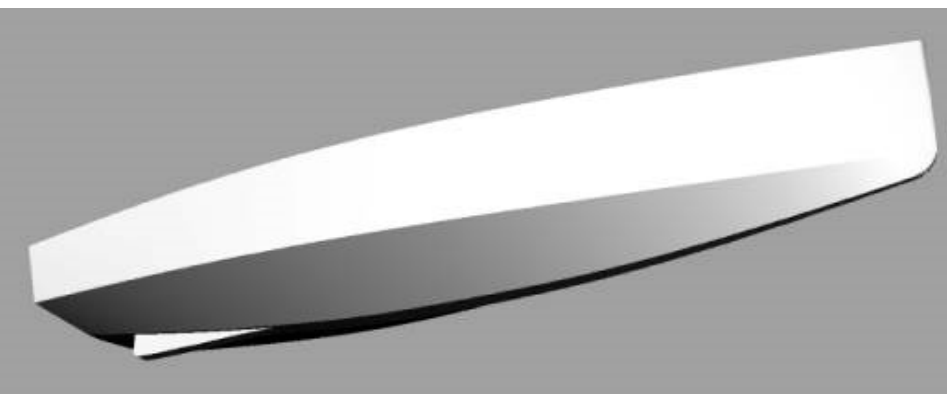
Figure 7. The KISS prototype’s hull form development.